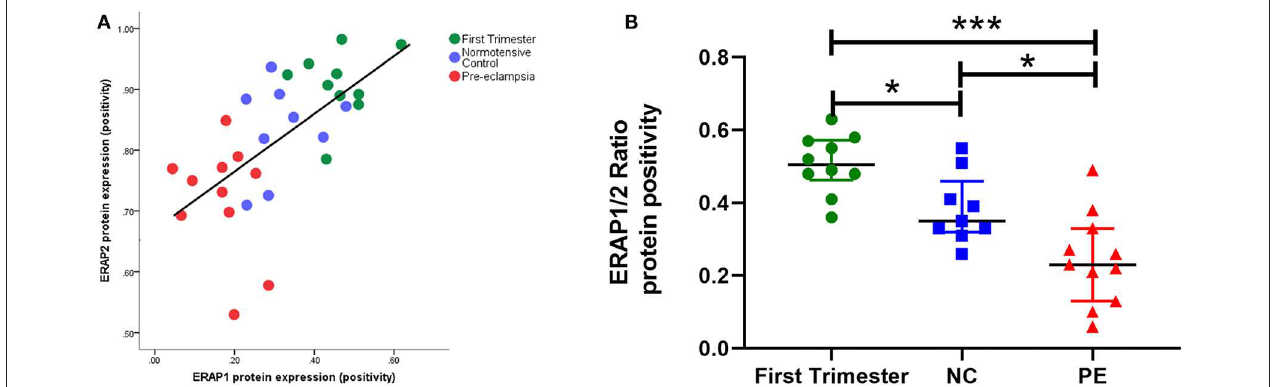
FIGURE 3 | (A) Scatter plot illustration shows a strong positive correlation between endoplasmic reticulum aminopeptidase (ERAP)1 and ERAP2 placental protein expression ( r = 0.70; P < 0.0001); (B) box plots of ERAP1/ERAP2 ratios in first trimester tissue ( n = 12), normotensive control (NC; n = 12), and pre-eclampsia (PE; n = 12). Data are presented as median [interquartile range (IQR)]; * P < 0.05; *** P <